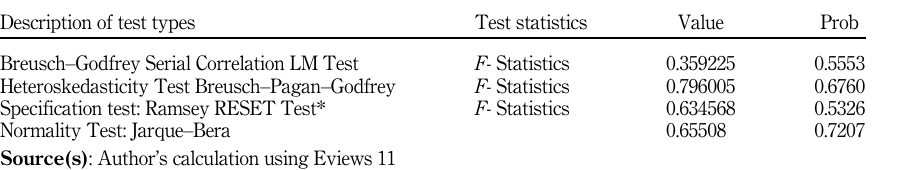
Table 5. Diagnostics tests